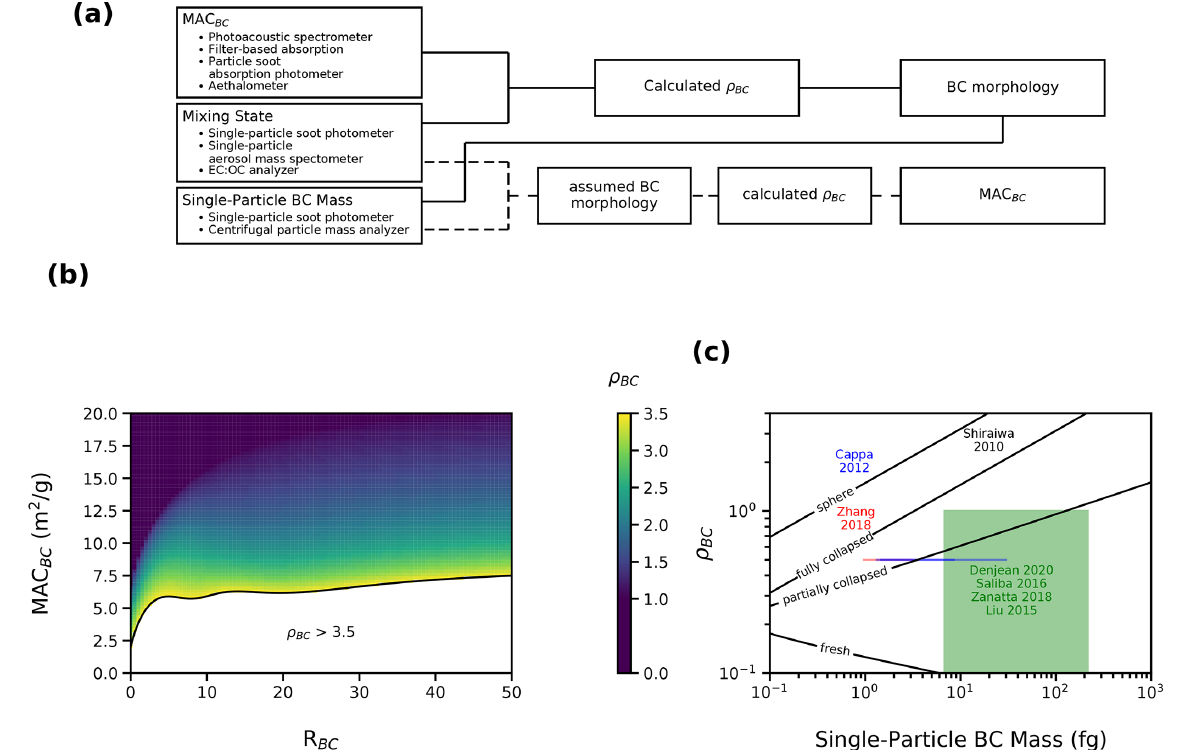
Figure 8. (a) Flowchart for forward (dashed lines) and inverse (solid lines) procedures of the Python BC absorption module (pyBCabs), which uses three measured properties: mass absorption cross-section (MAC BC ), coating amount ( R BC ), and single-particle BC mass. In the forward procedure, the assumed BC morphology is combined with the single-particle BC mass to calculate MAC BC (dashed lines). In the inverse procedure (solid lines), measurements of MAC BC and R BC are first input to panel (b) in order to constrain the core phase shift parameter ( ρ BC ). Then, ρ BC and the single-particle BC mass are input to panel (c) to estimate the BC core structure. This procedure has been carried out for data from three studies, and we find that low MAC BC from these studies can be explained by extensive compaction of the BC core (Cappa et al., 2012; Shiraiwa et al., 2010; Zhang et al., 2018). The procedure outlined in panel (a) has also been carried out for data from several studies, which found significant increases in MAC BC with increasing R BC and that the core morphology lies between fresh and partially collapsed BC (Saliba et al., 2016; Liu et al., 2015; Denjean et al., 2020; Zanatta et al., 2018). The examples shown here are all calculated assuming κ coat = 0 .